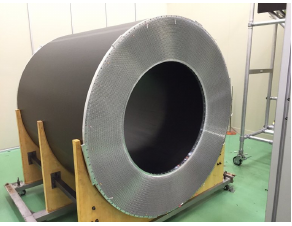
Figure 5. The test of the StrECAL prototype at Tohoku